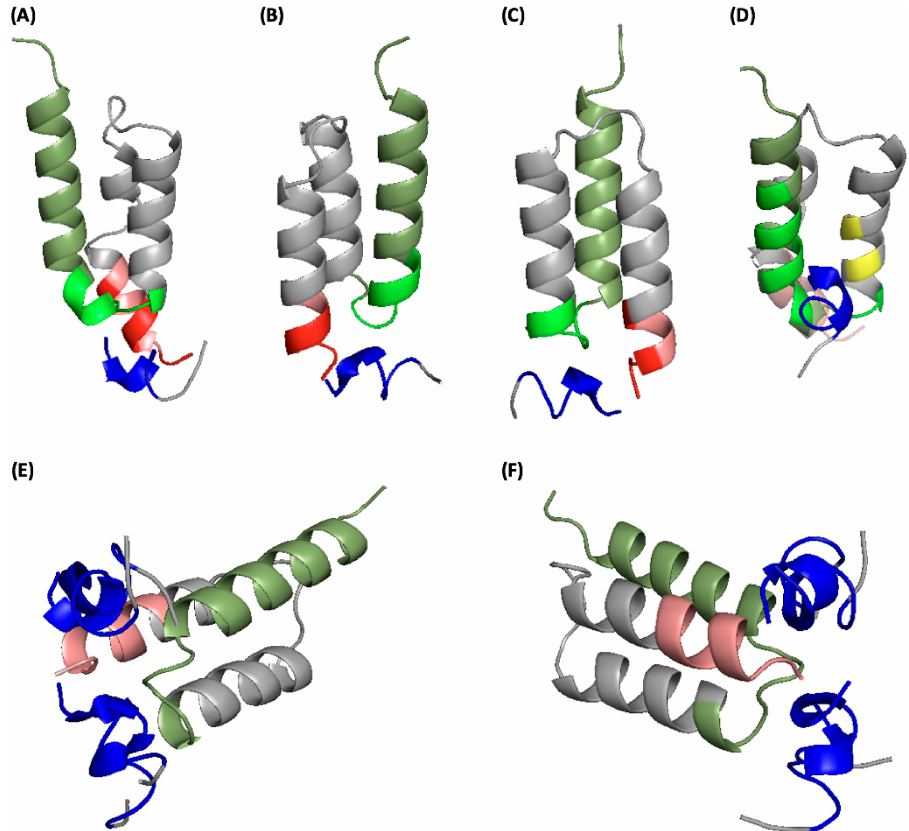
Figure 4. Docking of the IGKQRI–GSG peptide on ( A ) amyloid beta A4 protein-binding a ffi